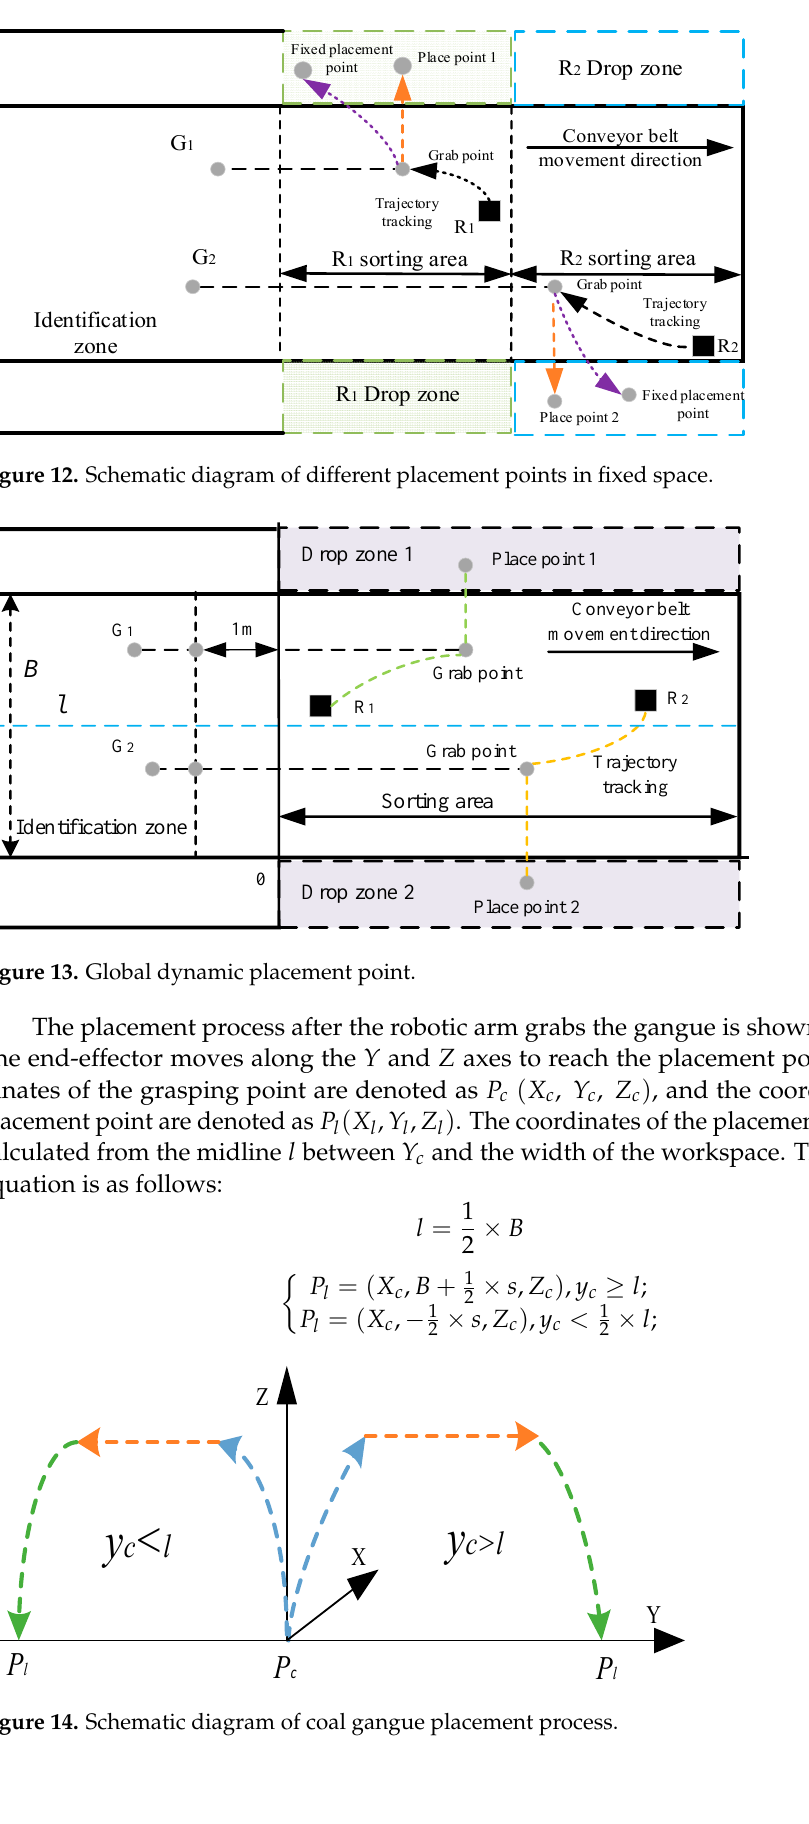
Figure 14. Schematic diagram of coal gangue placement process.